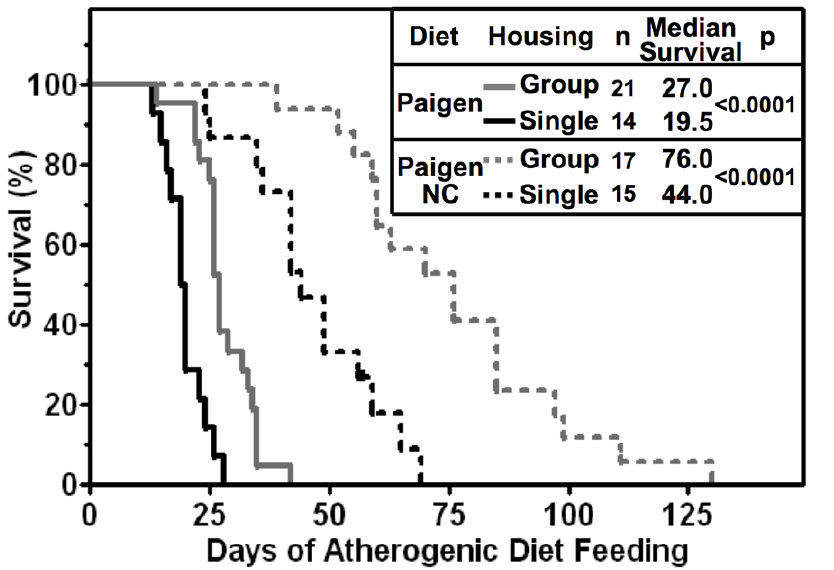
Figure 4. Effects of population density and atherogenic diets on the survival of Paigen diet-fed HypoE mice. HypoE mice were housed singly (1/cage, black lines) or in mixed genotype groups (HypoE and one or more SRBI + / 2 ApoeR61 h/h littermates per group, 4–5/cage, gray lines). Beginning at two months of age the animals were switched from a normal chow diet to either the standard Paigen (solid lines) or Paigen NC (dashed lines) diets. The Kaplan-Meier survival curves shown include only the HypoE mice. A notch in the singly housed HypoE mice fed the Paigen NC diet indicates a censored animal, which was euthanized due to severe ulcerative dermatitis at 57 days after initiating Paigen NC diet feeding.